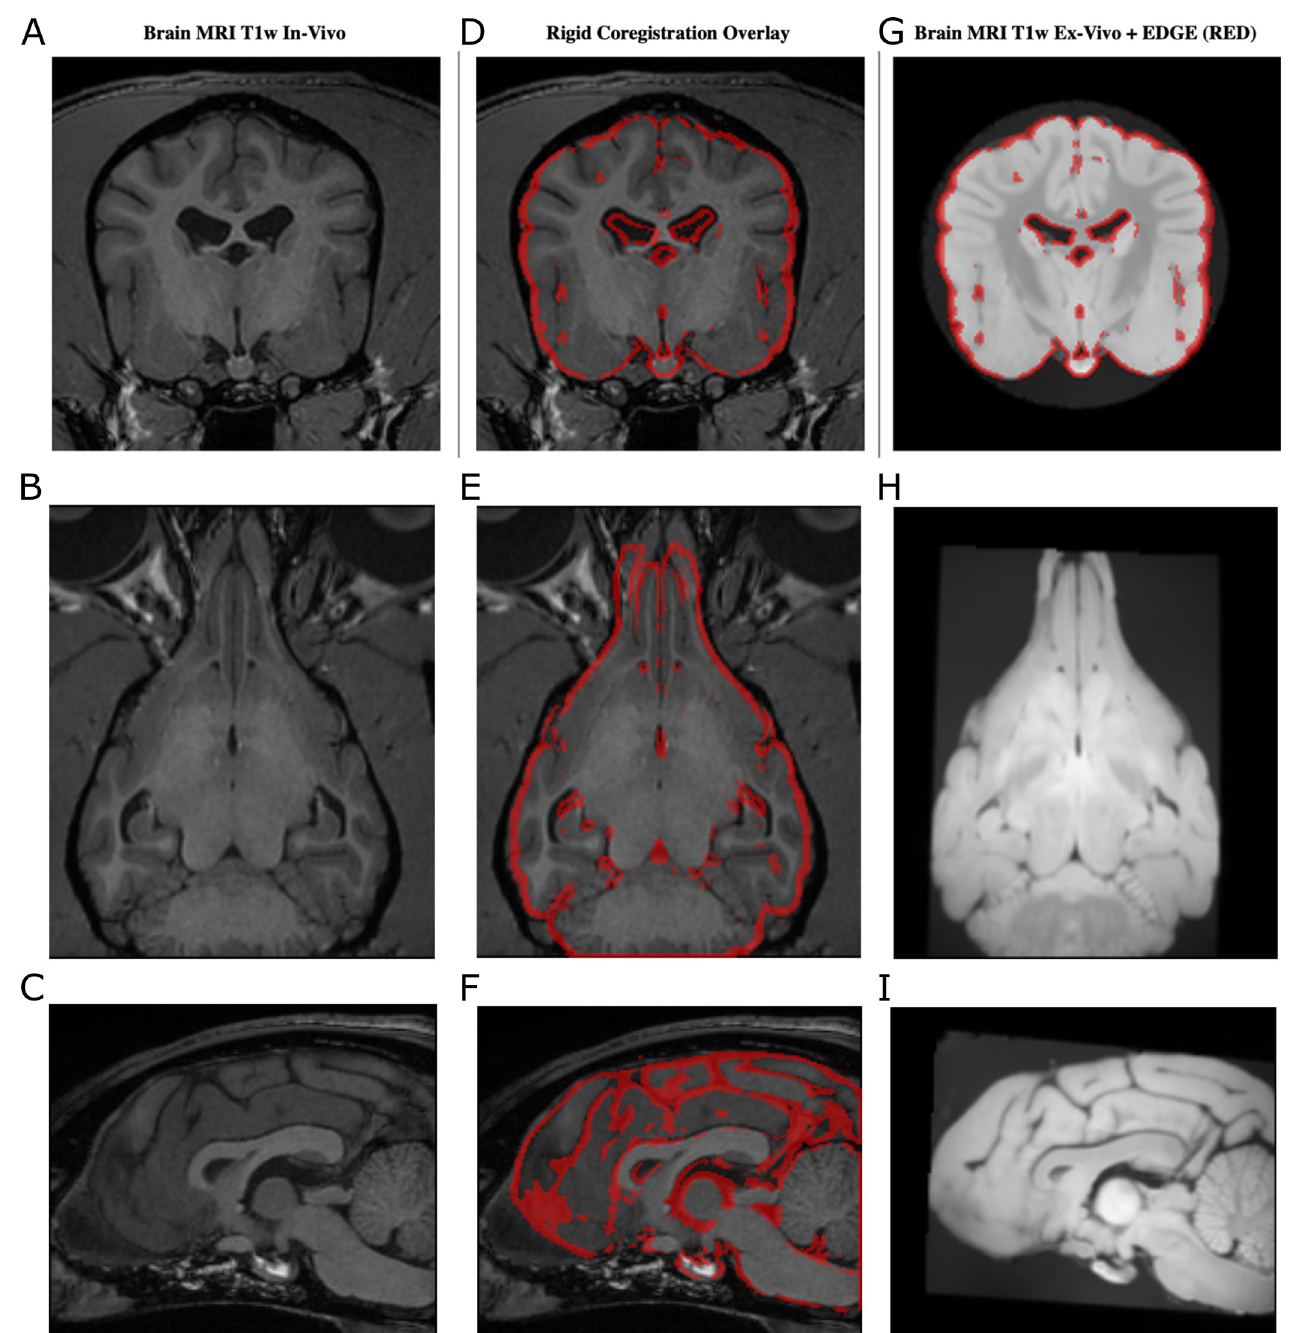
Fig 6. Data coregistration. T1w in vivo data are used as the reference to coregister the ex-vivo data with a 6-parameter coregistration approach (no scaling included). As an example, a representative subject is reported (A-C). The in vivo brain contours are overlaid to the ex-vivo data after the coregistration (D-F). It can be noted a good agreement. Analogously, the in-vivo brain contours overlaid on the ex vivo 12 months show that the rigid coregistration successfully aligned the data (G-I). Since no scaling was involved in the data transformation, this suggests that the brain did not experience any significant inflation/